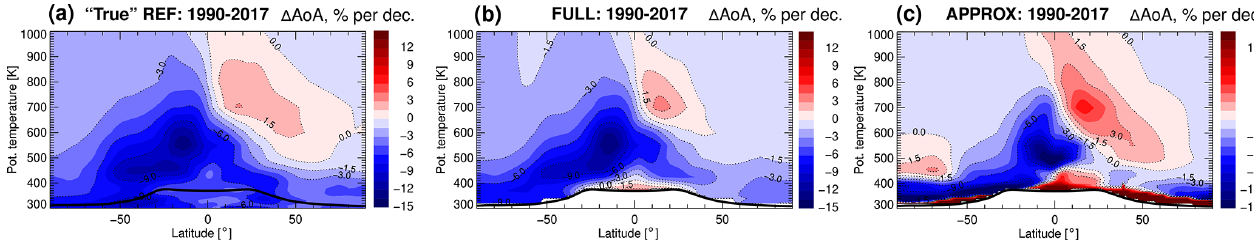
Figure 5. Decadal changes of AoA during 1990–2017. Decadal changes of AoA during 1990–2017: (a) true AoA changes from the CLaMS simulation driven by ERA-Interim reanalysis, (b) using CH 4 propagation by CLaMS age spectrum and monthly varying AoA–FRF corre- lation (FULL), and (c) AoA changes estimated with the approximation method (APPROX). The changes are presented in percentage per decade relative to the AoA 1990–2017 climatology in each used method of AoA calculation. The black line is the tropopause calculated from